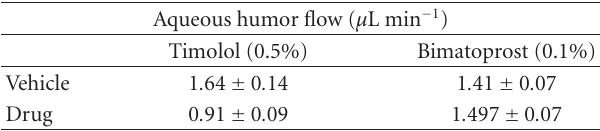
Table 1: E ff ect of bimatoprost (0.01%) administered twice daily for 5 days on total outflow facility in ( μ L min − 1 mmHg − 1 ) cynomolgus monkeys, n = 6 (Mean ± SEM).